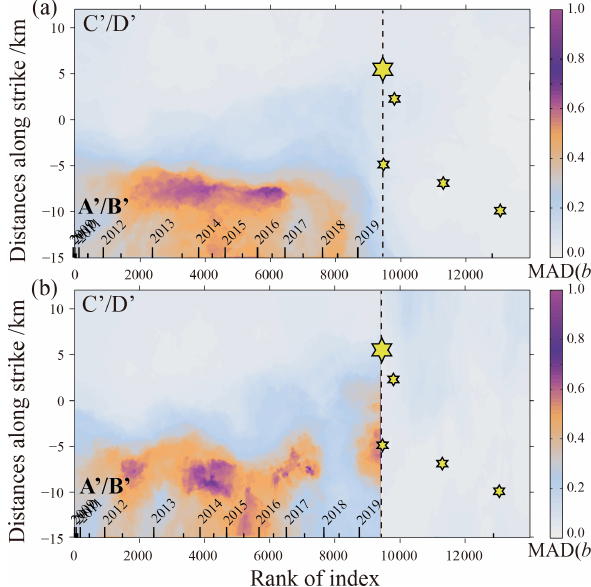
Figure 6. Spatiotemporal distribution of the ensemble median b val- ues of the best-100 solutions for N v = 2–40 in a 2-D space con- sisting of the distance along strike and rank of index. (a) The en- semble median b values obtained from all data before and after the Changning M S = 6 . 0 earthquake; (b) the ensemble median b values obtained from the data before and after the Changning M S = 6 . 0 earthquake considered separately. The vertical dotted line shows where the M S = 6 . 0 earthquake occurred. The timescale is marked on the x axis (above the axis), including the time of whole years marked by long ticks and the half-year time marked by short ticks.